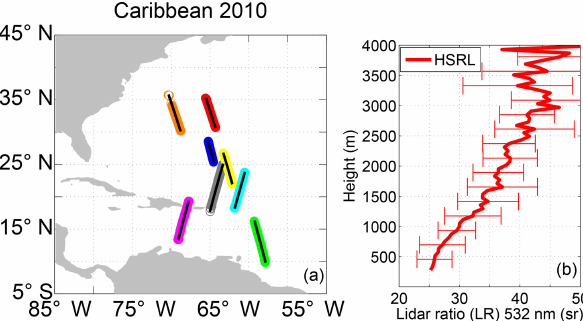
Figure 1. (a) Flight tracks during the 2010 field campaign (colored for individual flight missions). Black solid lines correspond to the matched CALIPSO tracks. (b) Mean HSRL lidar ratio (532nm) as a function of altitude and 1 standard deviation (error bar) for all the flight tracks in Fig.